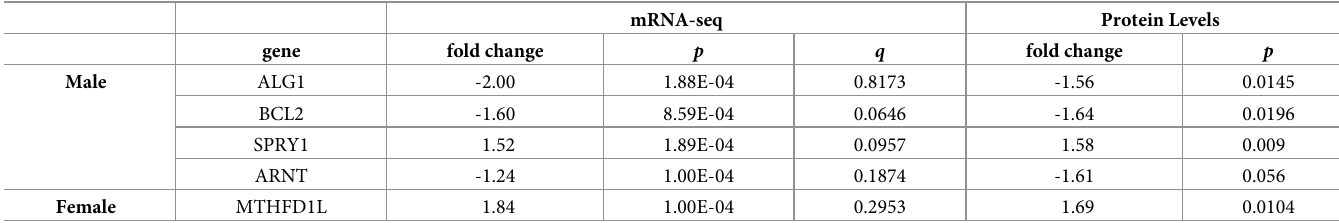
Table 5. Genes with correlating RNA-Seq and protein levels.